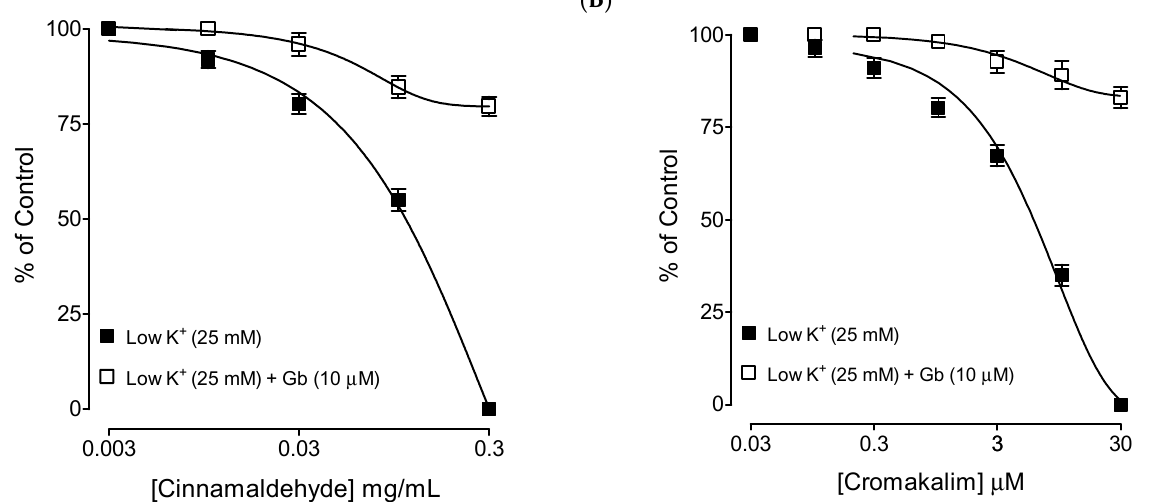
Figure 6. Concentration-dependent inhibitory effect of ( A ) cinnamaldehyde and ( B ) cromakalim, against low K + (25 mM) in the absence and pretreatment with glibenclamide (Gb; 10 µ M) using isolated guinea pig tracheal strip preparations. Results are expressed as mean ± SEM, n = 4.